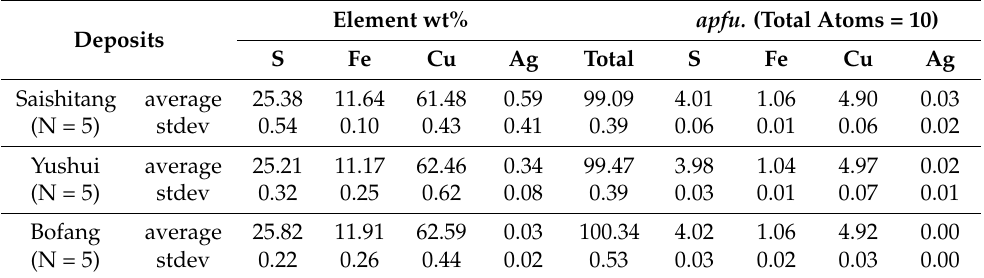
Figure 1. Photomicrographs showing occurrences and mineral associations of bornite. ( a ) Agglomerate of bornite, chalcopyrite, cobaltite and stannoidite filling intergranular space of andradite (Sample no. KD56a04) from the Saishitang skarn copper deposit. ( b ) Massive bornite with disseminated betekhtinite, chalcocite and stromeyerite (Sample no. Yus04) from the Yushui spouting hydrothermal copper deposit. ( c ) Euhedral bornite grains in colloidal chalcopyrite and tetrahedrite (Sample no. TGT1202b) from Tonggutang of the Bofang sandstone copper deposit. Table 1. EPMA analyses of bornite. Calculated composition ratio for each element is based on the Cu 5 FeS 4 formula.